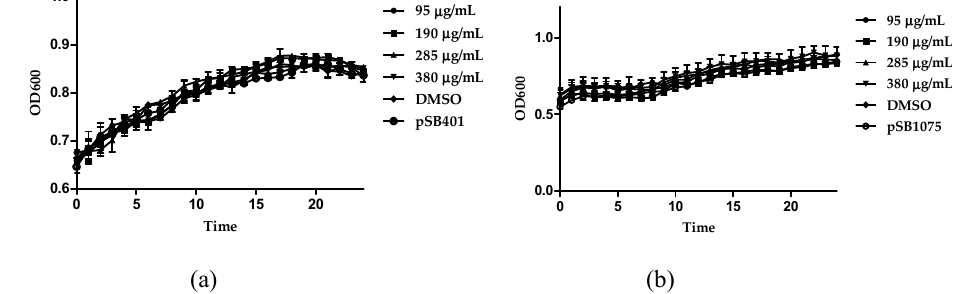
Figure 6. Growth effect of giganteone A with increasing concentration from 95 µg/mL (circle), 190 µg/mL (square), 285 µg/mL (triangle) to 380 µg/mL (inverted triangle) while DMSO (diamond) on ( a ) E. coli [pSB401] and ( b ) E. coli [pSB1075], respectively served as control (circle with hole). Data were analyzed by one-way analysis of variance with p < 0.05 being significant.